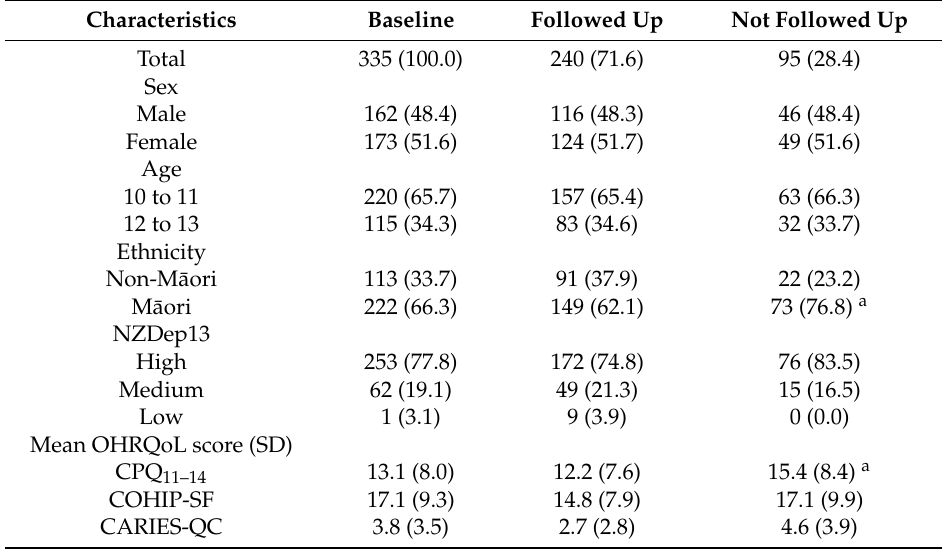
Table 5. Attrition analysis: comparison of the sociodemographic characteristics and oral health-related quality of life (OHRQoL) scale scores of children followed up and not followed up (brackets contain column percentages unless otherwise